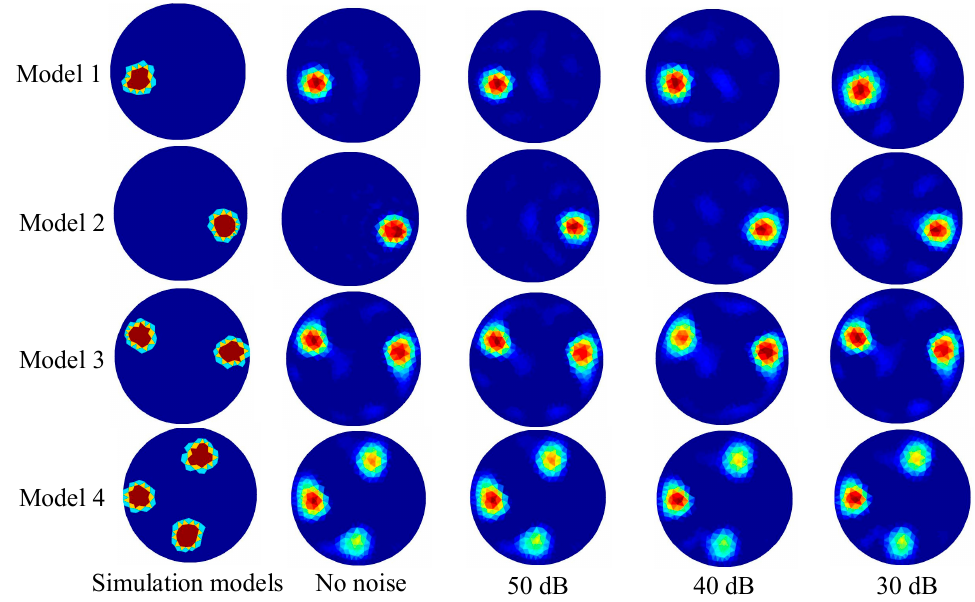
Figure 7. The reconstructed images of typical models with different noise levels using the proposed